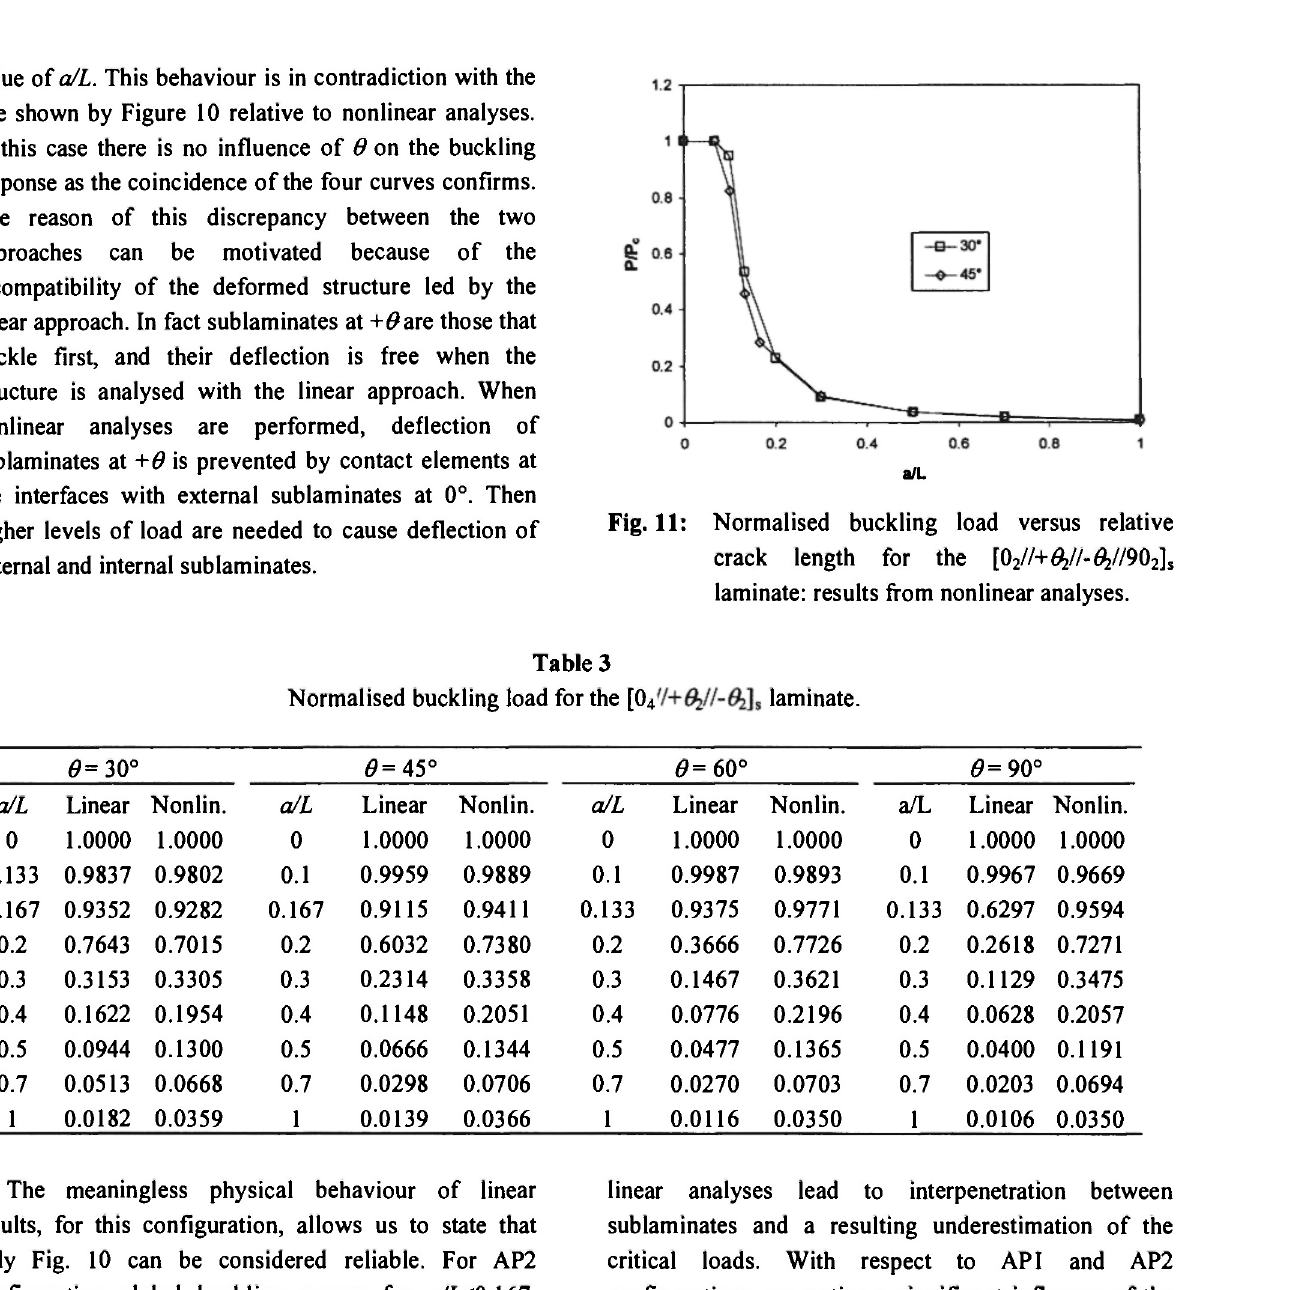
Normalised buckling load for the [ O 4 l a m i n a t